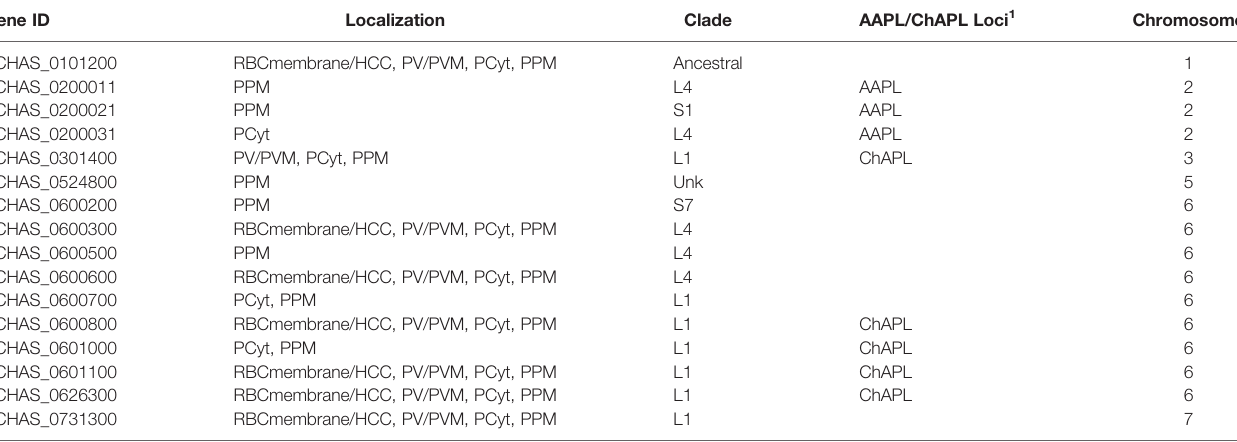
TABLE 2 | Localisation pattern of PIR proteins identi fi ed in proteome analyses of fractionated samples prepared from P. chabaudi infected erythrocytes at the chronic phase of infection. Gene